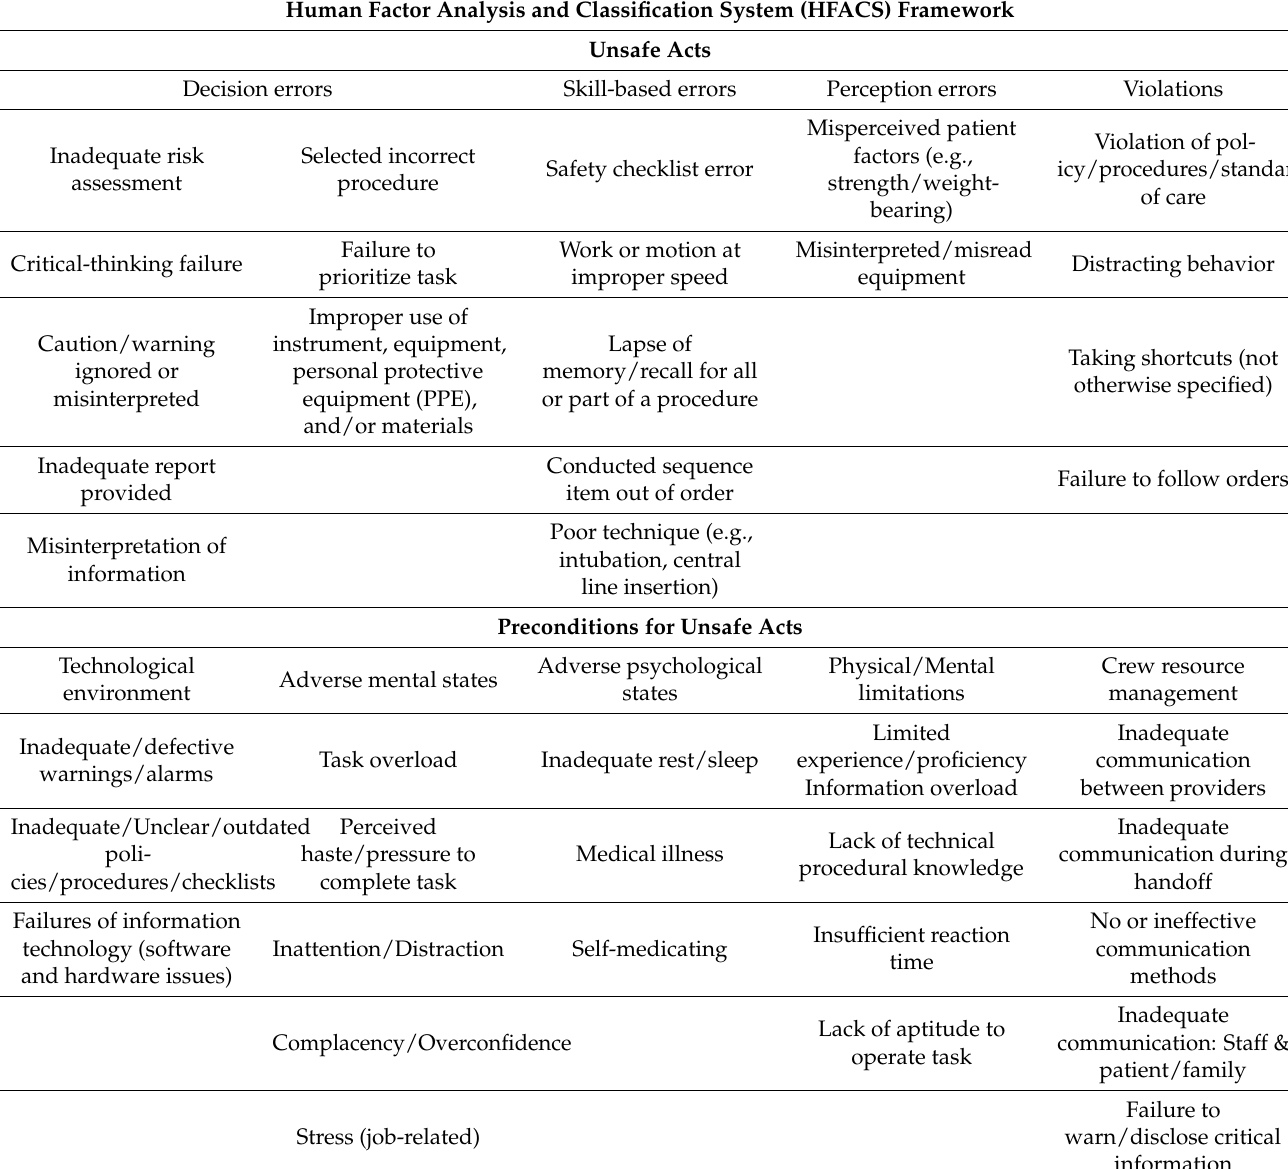
Table 1. Subfactor types that exist in adverse medication